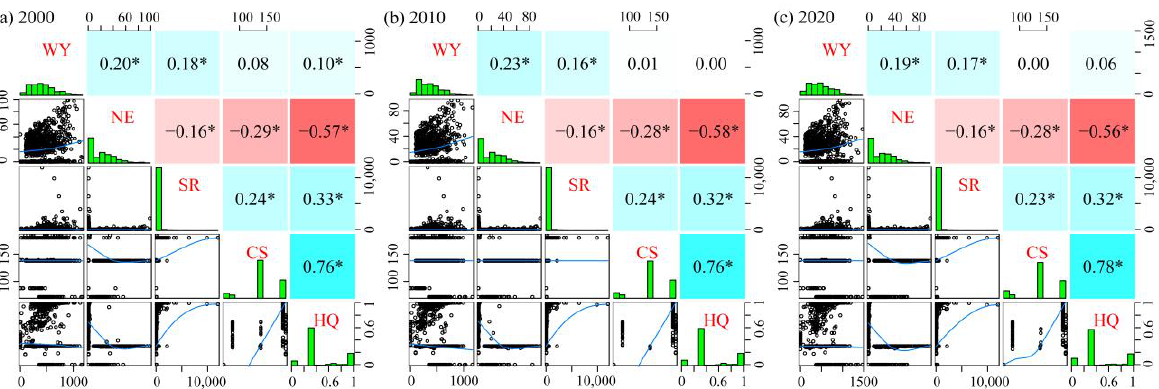
Figure 6. Pearson correlations between different ESs. WY: water yield; NP: nitrogen export; SR: soil retention; CS: carbon storage; HQ: habitat quality; * Correlation significant at p < 0.05 (two-tailed).